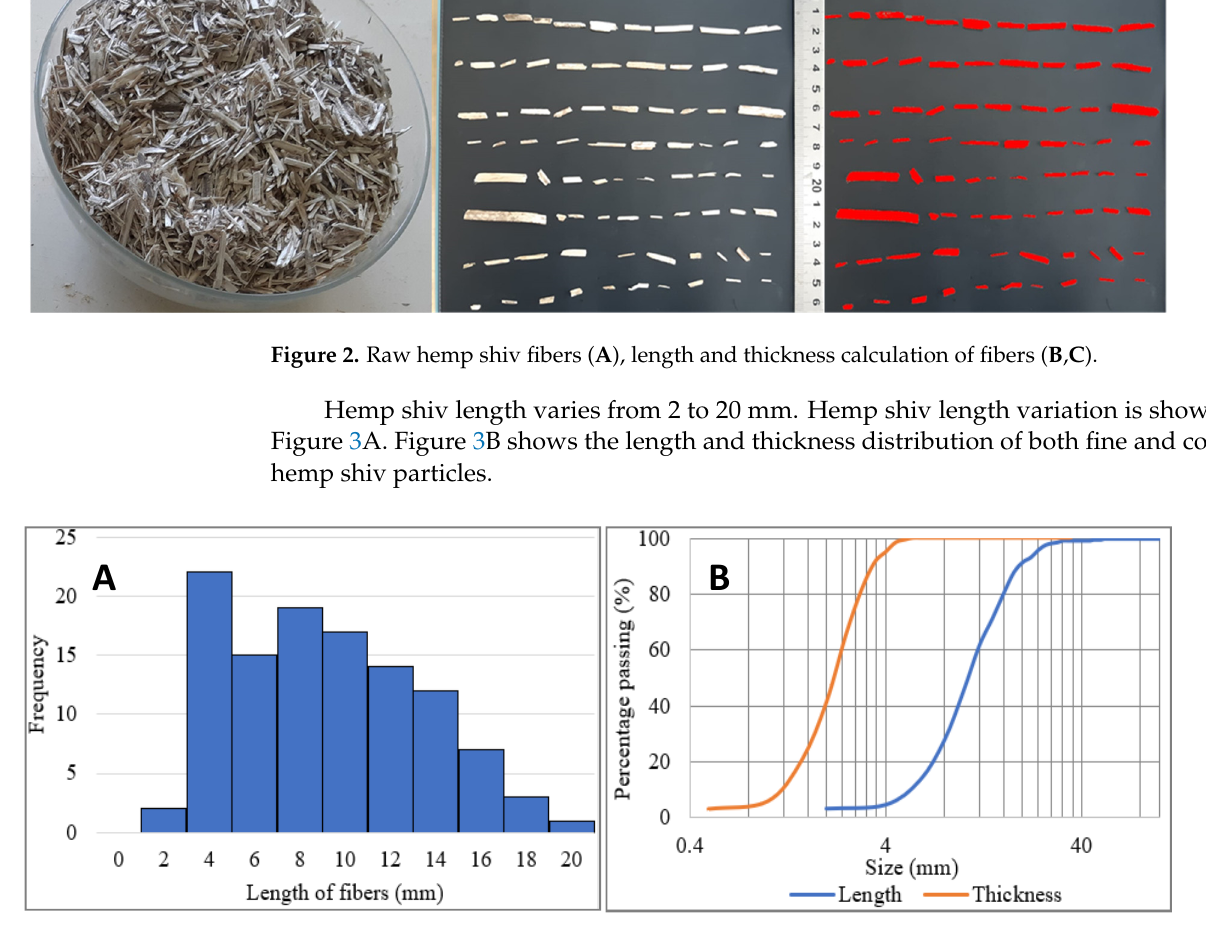
Figure 3. Length of hemp shiv ( A ), length and thickness distribution ( B ) of hemp shiv. Water absorption is another important property of natural fibers for their use in bricks. The water absorption of hemp shiv was found by immersing the hemp shiv in distilled water for 48 h. Fibers were rotated in a perforated container, 100 times with two revolutions per second to remove the water on the surface of the fiber. The water absorp- tion coefficient was measured at intervals of 30 min and 1, 4, 24, and 48 h to see the evo- lution of fiber water absorption.